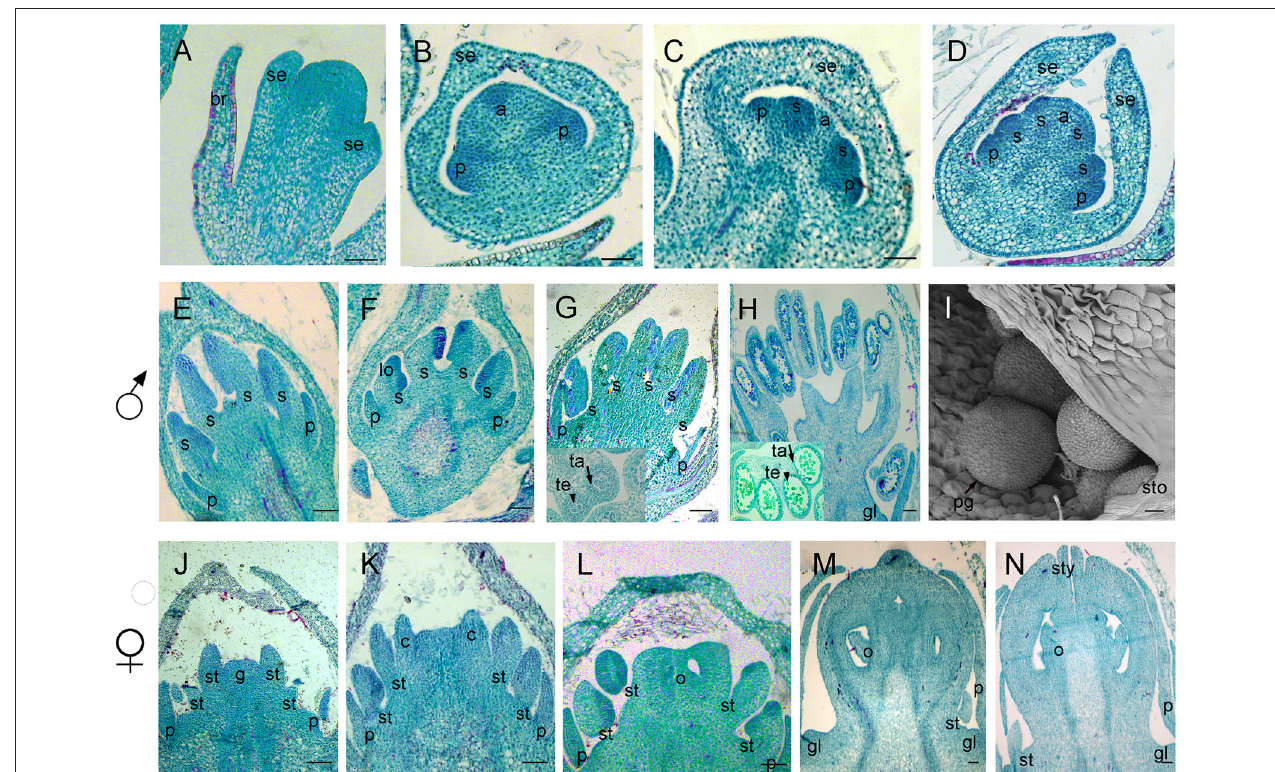
FIGURE 5 | Samples were sectioned into pieces with 8um thickness. Sections of flower development in V. fordii . (A) Stage 3. (B) Stage 4. (C) Stage 5. (D) Stage 6. (E) Stage 8 in the male flower: the filament and anther appeared. (F) Stage 9 in the male flower: locules formed with dense staining. (G) Stage 10 in the male flower: meiosis occurred and tetrads were surrounded by tapetum at the inset of the transverse section. (H) Stage 11 in the male flower: the tapetum layer began to disintegrate and pollen grains were round. (I) SEM of stage 12 in the male flower: the pollen grains were mature and released from the stomium. (J–N) Stages 8–12 of female floral development in which detailed description of each stage seen in Figures 4B–F , respectively. br, bract; se, sepal; p, petal; s, stamen; lo, locule; ta, tapetum; te, tetrad; sto, stomium; pg, pollen grain; st, staminode; g, gynoecium; c, carpel; o, ovule; sty, style; gl, gland. Scale bar =